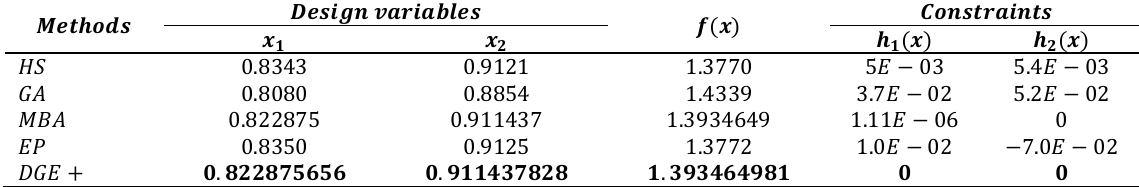
Table 2 . Reported results for constrained problem 1 from different